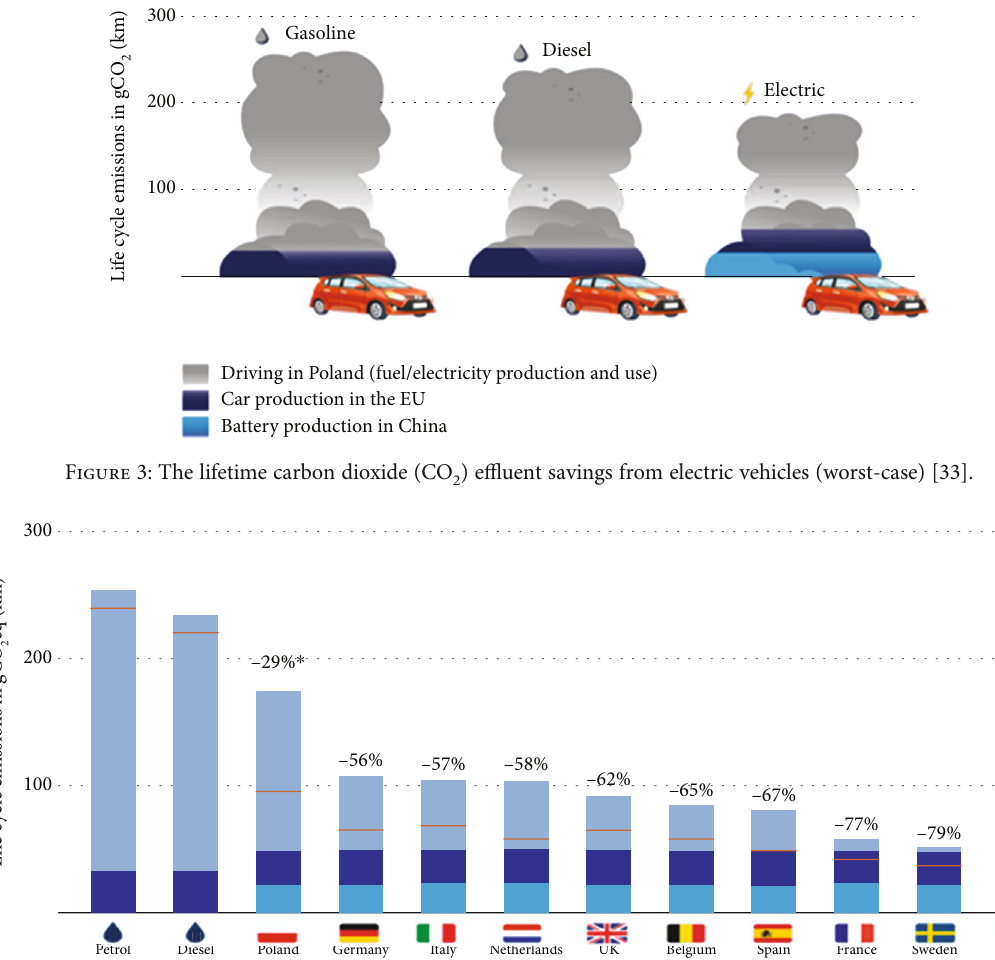
) emission savings from electric vehicles (best case scenario) 2